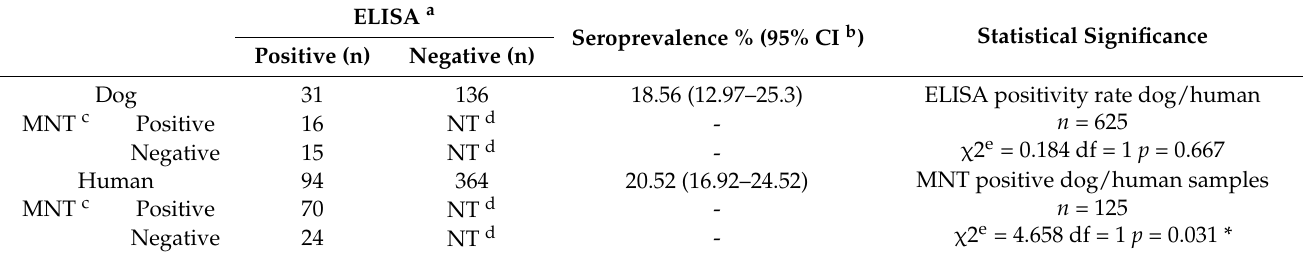
Table 3. Seroprevalence among dogs and humans from Zagreb sampled in December 2020. ELISA a Seroprevalence % (95% CI b ) Statistical Significance Positive (n) Negative